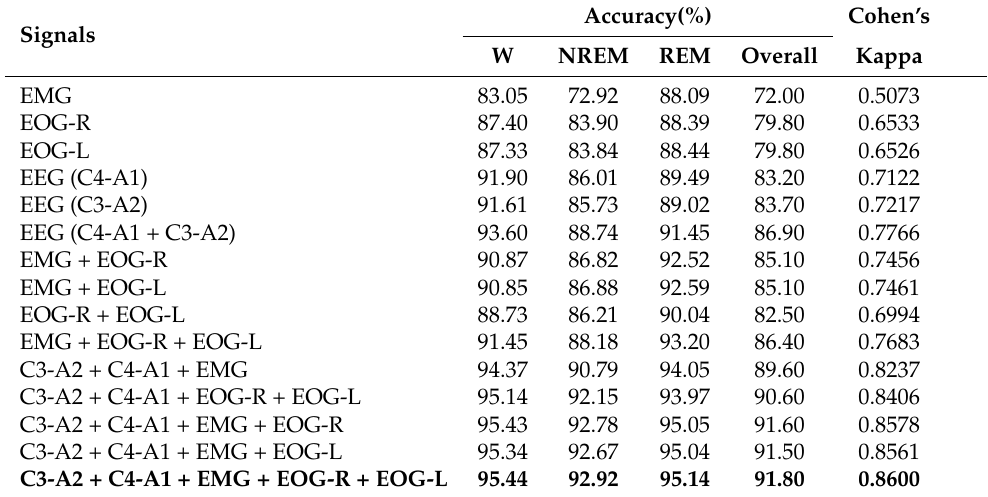
Table 3. Classification performance using different combinations of channels for classifying three sleep stages using SHHS-2.